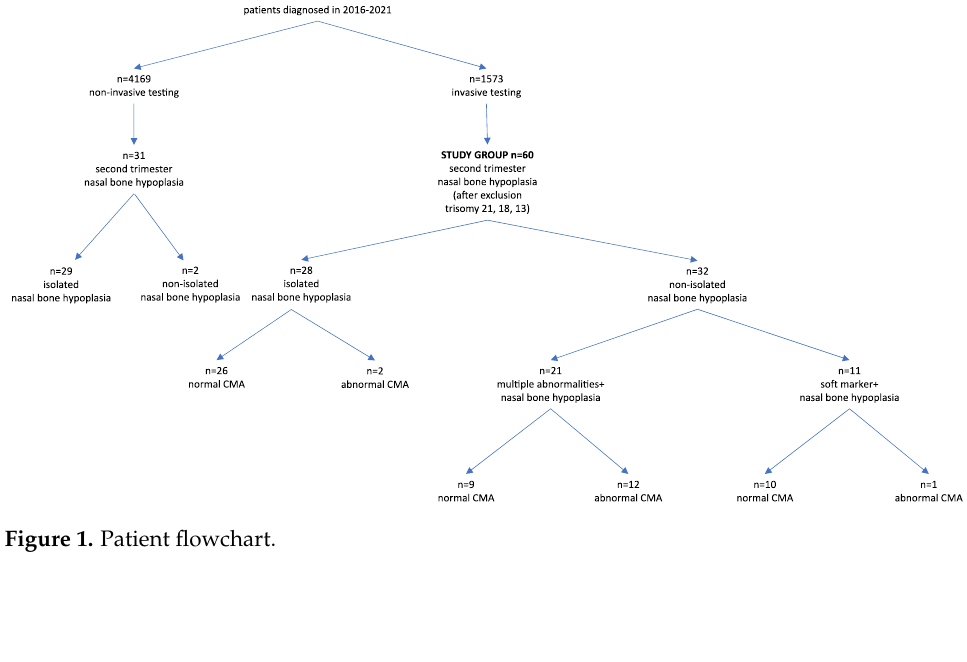
Figure 1. Patient flowchart.